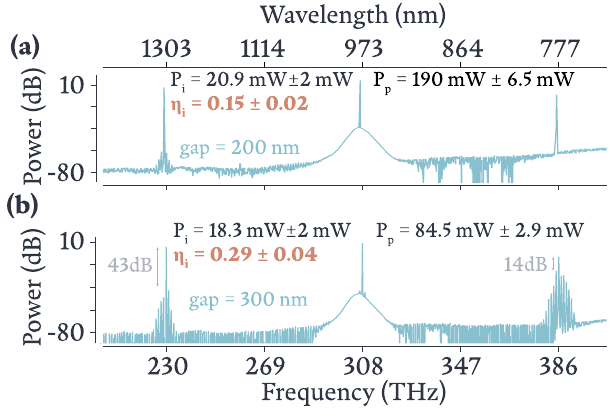
Fig.4|Highestoutputpowerandconversionef fi ciencyOPOs.a Spectrumofthe greatest output power OPO, which was achieved with a 200nm gap and has P i beyond20mW,albeitataconversionef fi ciencyof η i ≈ 0.14.Athighoutputpowers, thisdevicecontinuestoshowisolatedOPO.TheloadedQsfortheidler,pump,and signalare6.1×10 4 , 2×10 5 , and 1.2×10 6 , respectively, for the 200nm coupling gap. b Spectrum of the greatest conversion ef fi ciency OPO, which was achieved with a 300nm gap and has η i approaching 30%, at the expense of additional parametric sidebands. The loaded Qs for the idler, pump, and signal are 3×10 5 , 1.6×10 6 , and 4×10 6 , respectively, for the 300nm coupling gap. In the idler band,the additional sidebands are>40dB below the idler, while in the signal band, the additional sidebands are>14dB below the